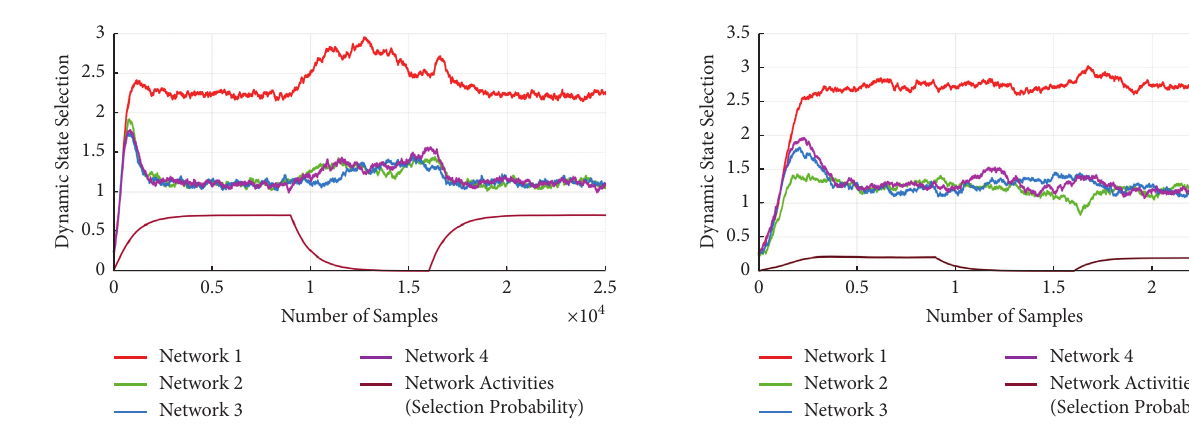
Figure 8: Effect of threshold on network connectivity for � 7 ) . sensitivity � 5 ( V thrl